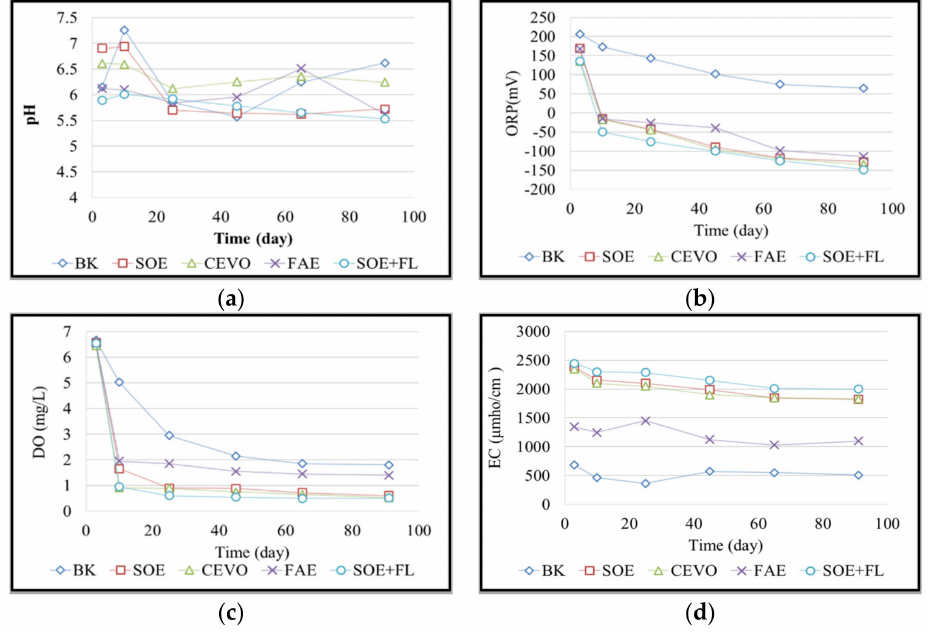
Figure 3. Environmental parameter variation in the microcosm tests: ( a ) pH; ( b ) ORP; ( c ) DO; and ( d ) EC.